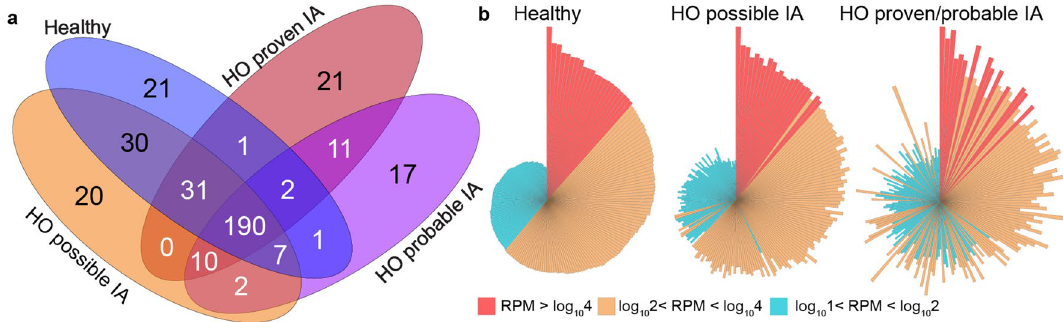
Figure 1. Conserved and unique miRNAs in different patient populations. ( a ) The number of individual and shared miRNAs was determined in healthy controls (H) and HO patients with proven (HO-proven), probable (HO-probable) and possible (HO-possible) IA. ( b ) Normalized distribution patterns of the 190 conserved miRNAs in the H, HO-possible and HO-proven/probable groups are shown as circo plots, where red, orange and blue correspond to miRNAs with high (RPM > log 10 4), medium (log 10 2 < RPM < log 10 4) and low (log